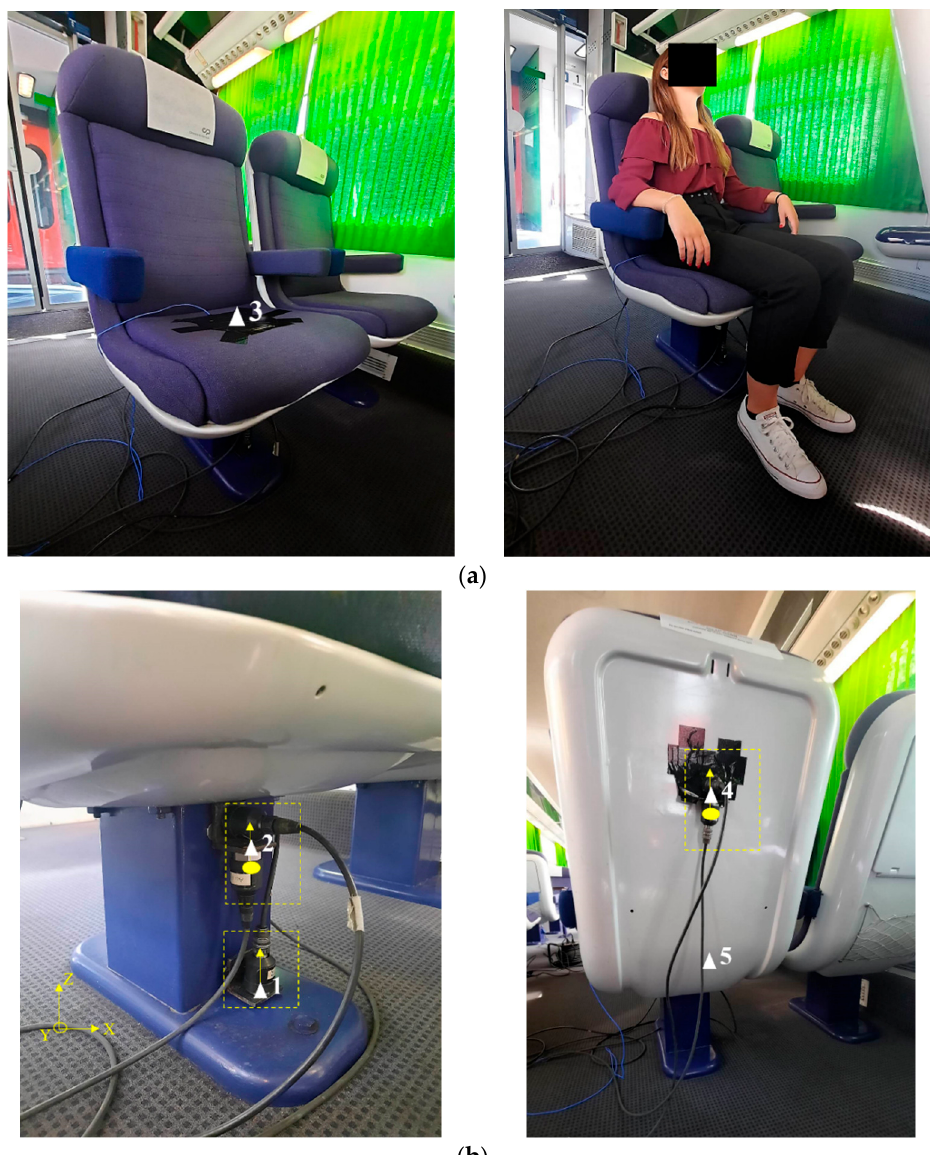
Figure 16. Experimental setup: ( a ) seat pad location; ( b ) accelerometers on seat frame structure.